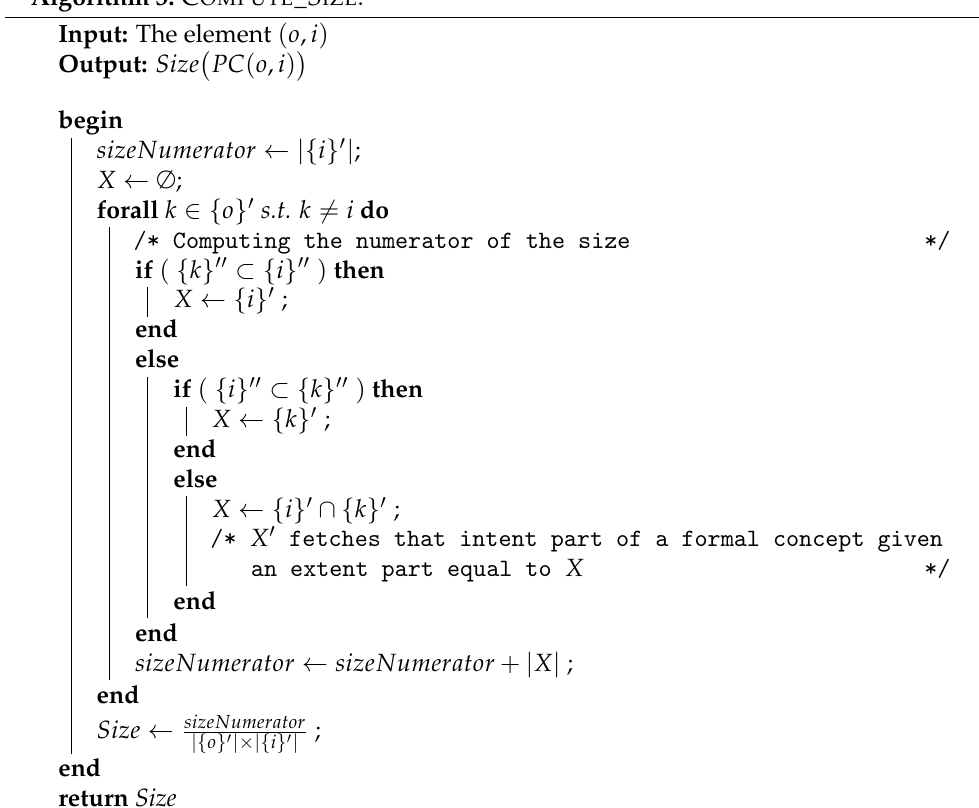
Algorithm 3: C OMPUTE _S IZE